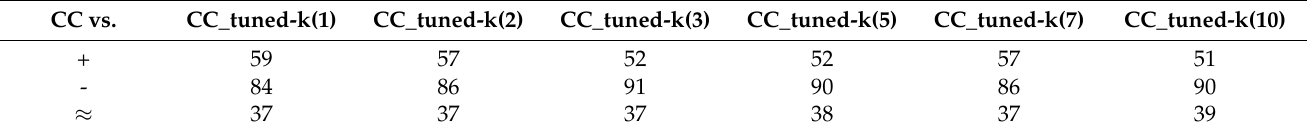
Table 5. The Wilcox rank-sum test CC vs. CC_tuned-k.